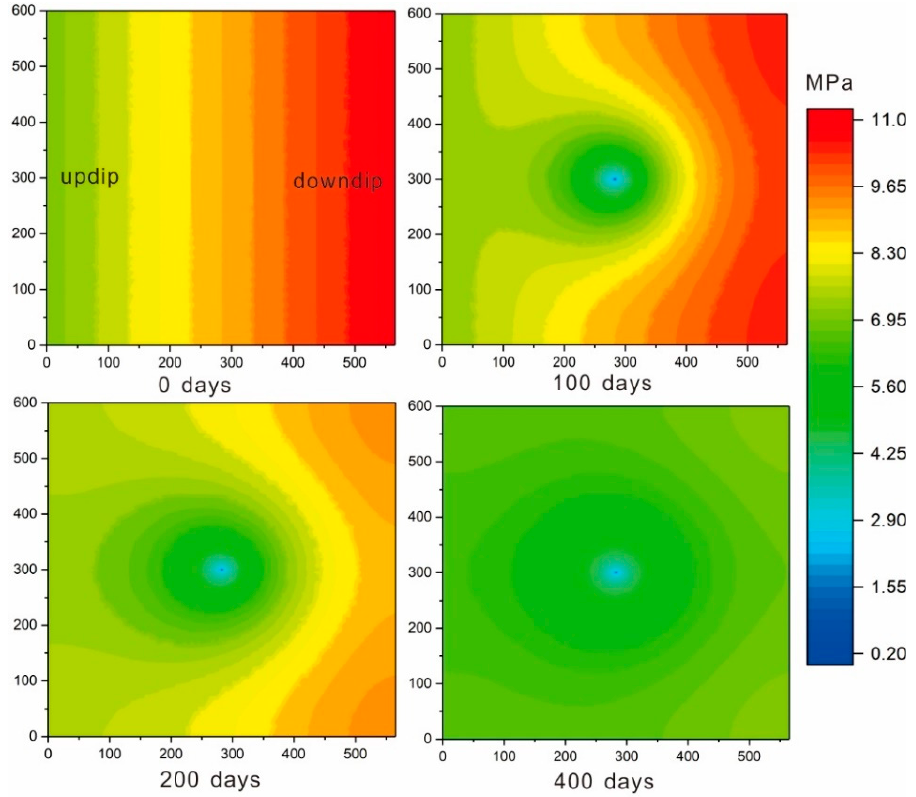
Figure 7. Nephogram of the reservoir pressure distribution (vertical view).